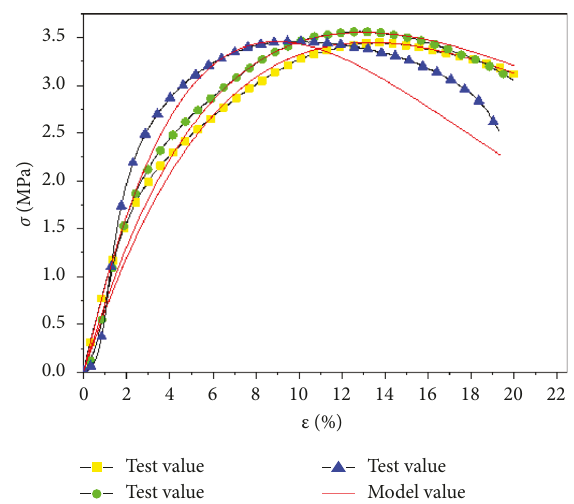
Figure 12: Comparison of model values and test values at − 15 °